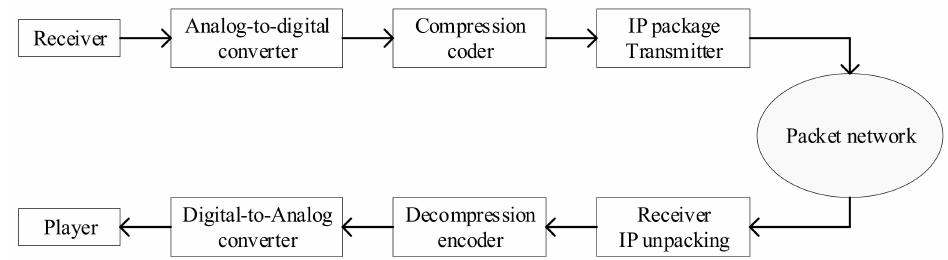
Figure 1. The basic process of VoIP transmission.